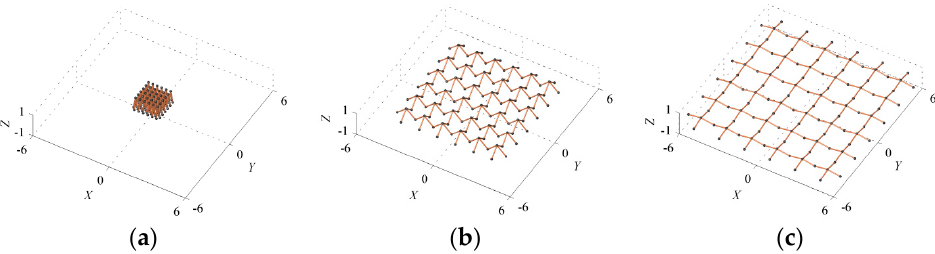
Figure 4. Motion of a deployable structure assembled by 6 × 6 basic units, with n 1 = 2 and n 2 = 4: ( a ) Folded configuration; ( b ) partially deployed configuration; ( c ) deployed configuration.